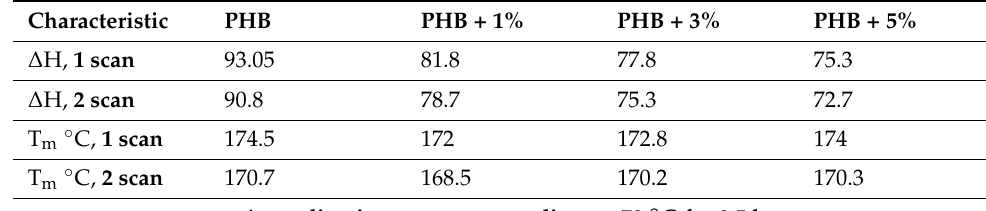
Table 1. Enthalpy ( ∆ H) and melting point (T m ) of ultrathin fibers of PHB/hemin mixtures studied by